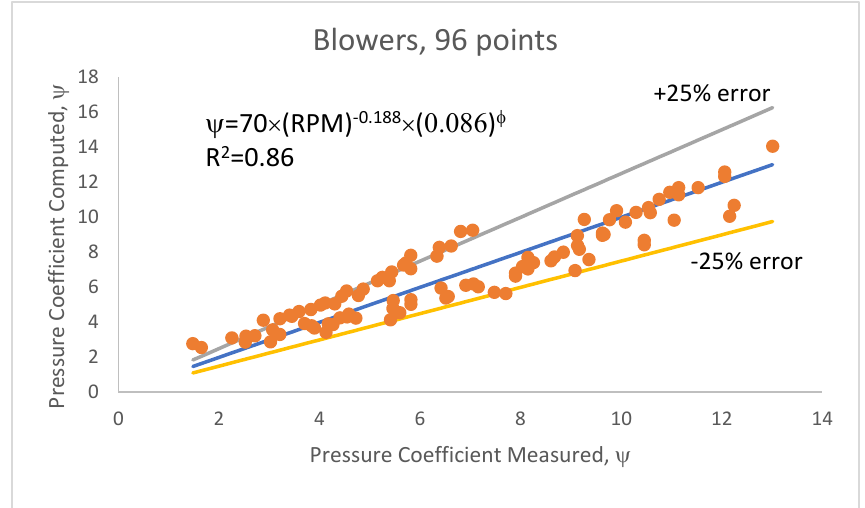
Figure 3. Computed vs. measured pressure coefficient for one ‐ side vane impeller blowers.